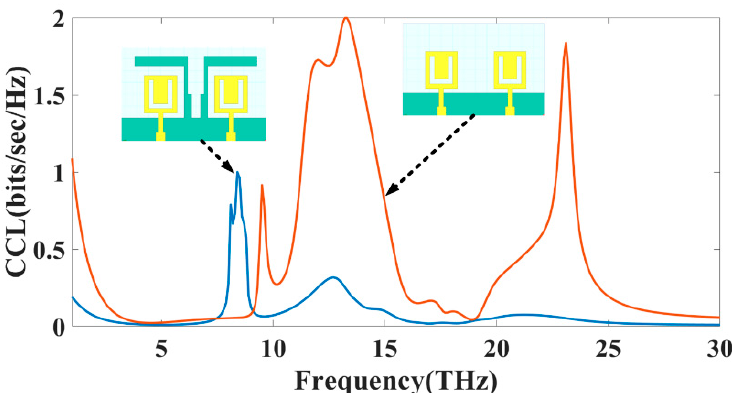
Figure 7. The simulated value of the CCL (dB) for MIMO structure Design 3 and Design 4.